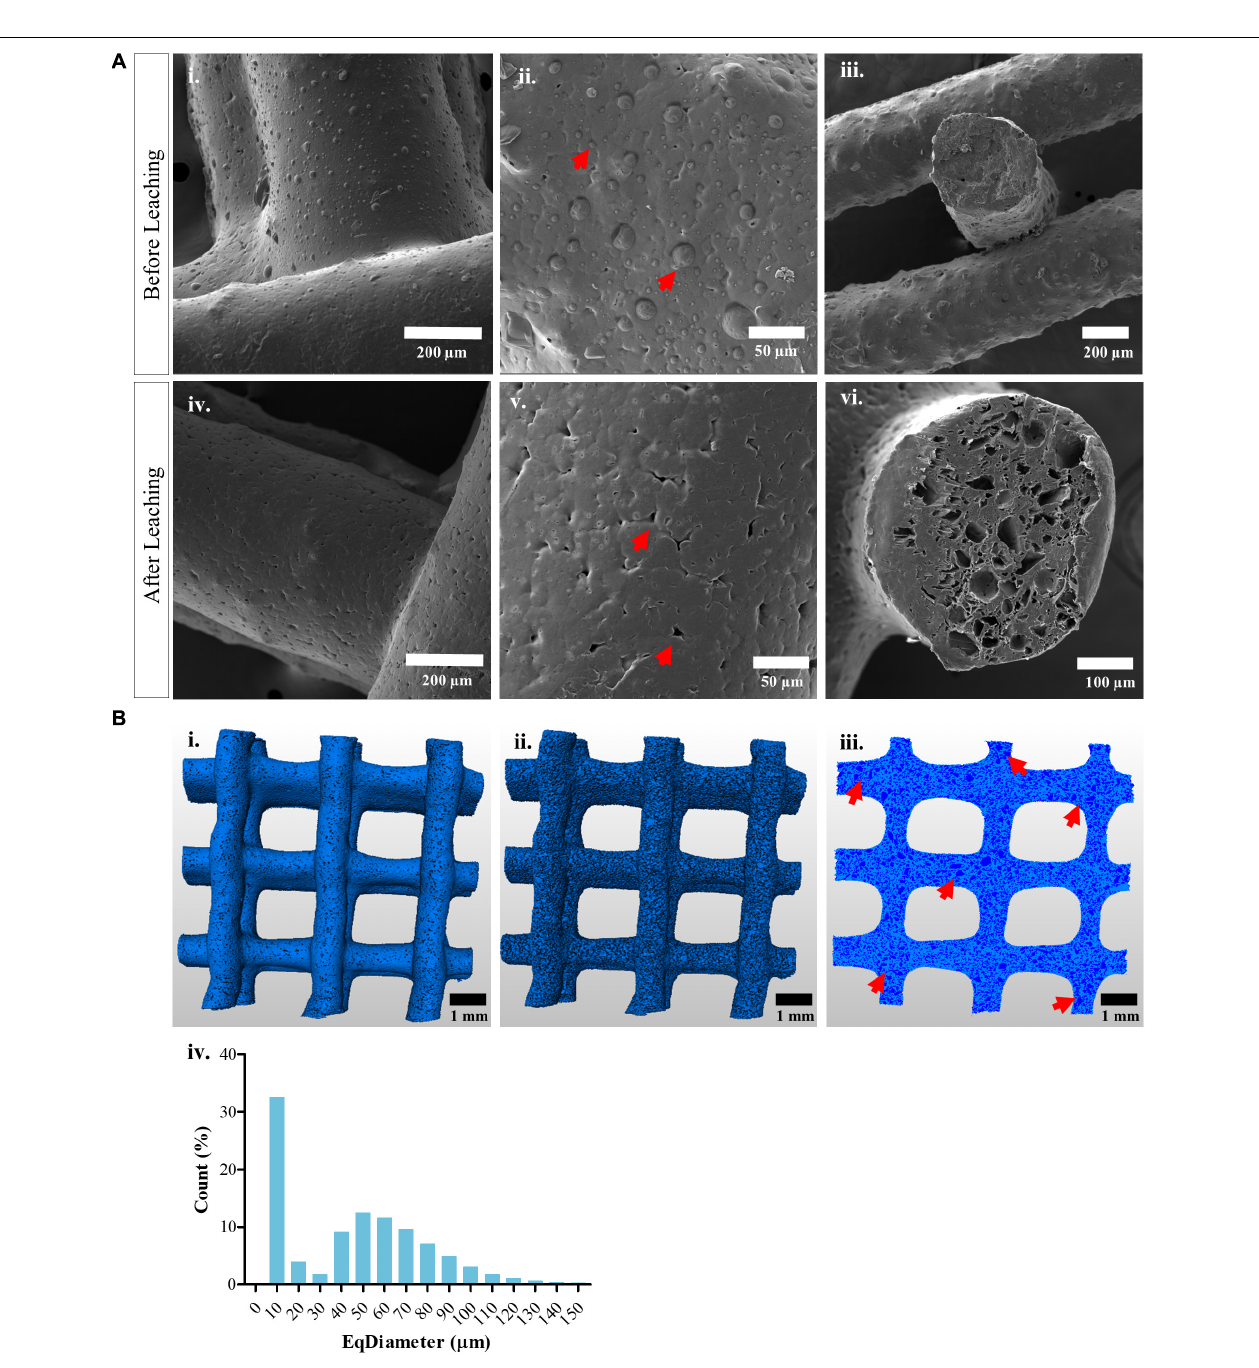
FIGURE 1 | Morphological characterization of macro- and microporous 3D printed scaffolds (A) Scanning electron microscopy images showing the surface of extruded mPCL/Sugar scaffolds (i–iii) after printing, red arrows indicate sugar crystals and (iv–vi) after leaching out the sugar particles for 15 days in order to generate micro-sized pores, which are indicated with red arrows. (B) µ CT evaluation of microporous mPCL scaffolds showing the 3D representation of the (i) segmented scaffold struts after sugar leaching as well as the (ii) segmented micropores. (iii) 2D distribution of micropores across a virtual plane through the scaffold, struts are shown in clear blue and micropores in dark blue, red arrows indicate local interconnectivity of pores. (iv) Equivalent diameter distribution for the micropores present on the surface of and within the scaffolds.